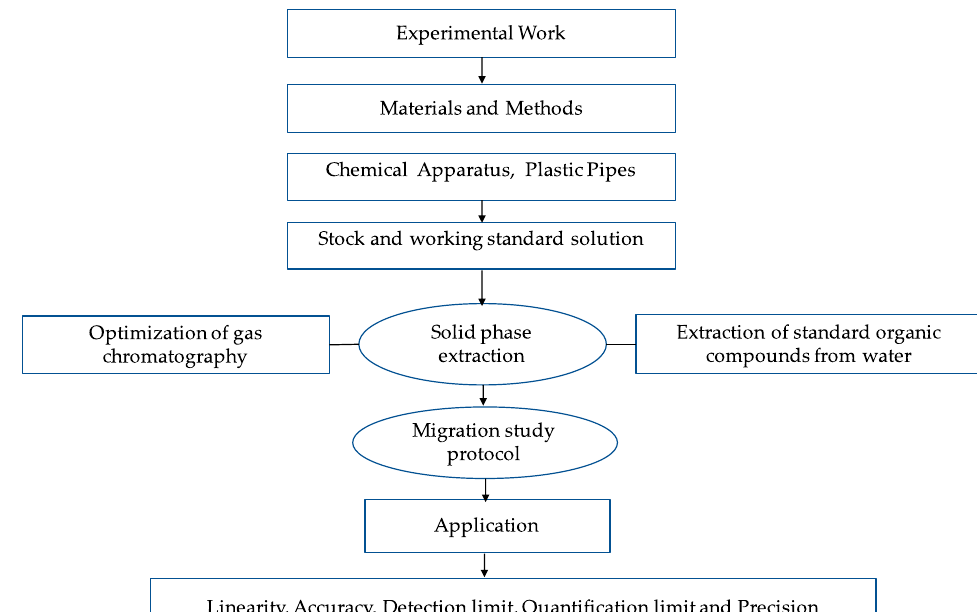
Figure 1. Flowchart of the experiment.